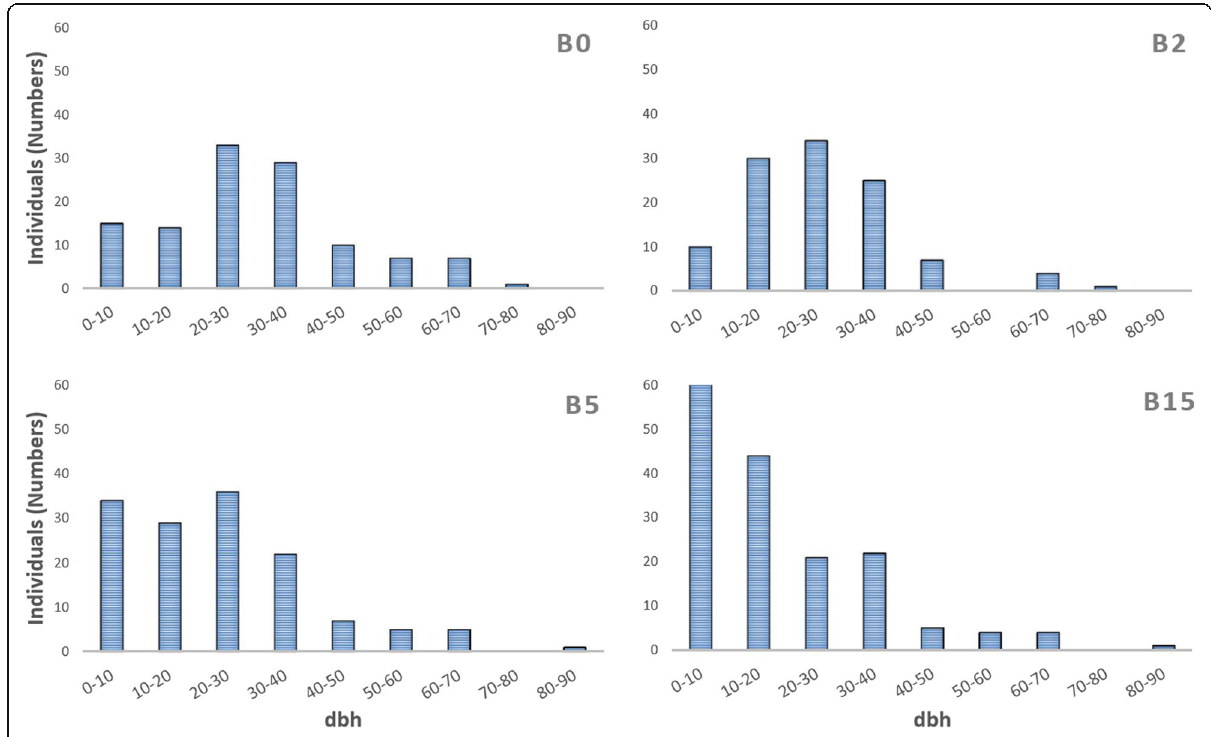
Fig. 3 Stem diameter distribution in burned and unburned classes